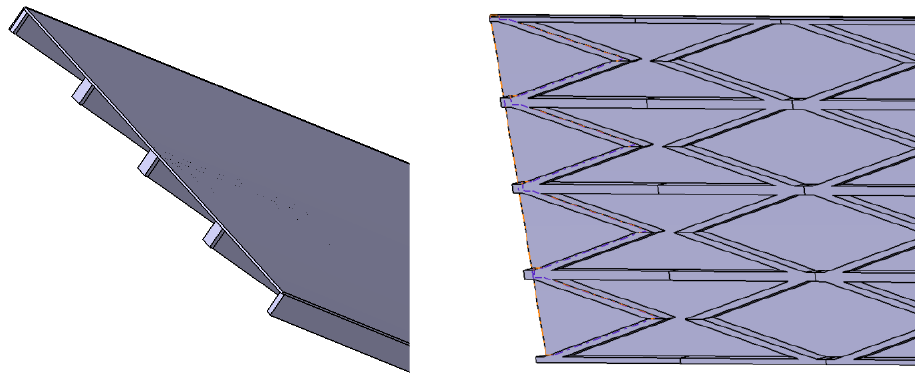
Figure 27. The real elastic shape of the wing ’ s skin.